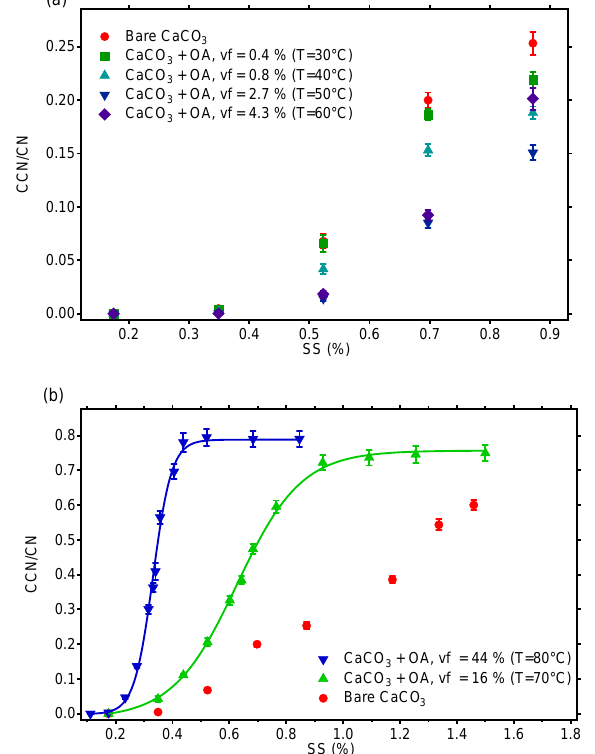
Figure 4. Activated fractions (CCN / CN) of monodisperse CaCO 3 aerosol particles (diameter d u = 101 . 9nm) at different supersatu- rations before and after OA coating. With increasing coating tem- peratures of 30–50 ◦ C the activated fraction decreases despite the increase of organic volume fraction (vf) from 0.8 to 2.7%. At a vf of 4 . 3% at 60 ◦ C this trend turns. Considering the increased particle diameter at 30–60 ◦ C and the reduced activated fraction simultane- ously, the CCN activity of the coated CaCO 3 particles at 30–60 ◦ C was lower than that of the uncoated CaCO 3 particles (a) . At coating vf of 16 and 44% ( T = 70–80 ◦ C) the activated fractions, and thus CCN activities, are higher than for bare CaCO 3 and increase with coating vf. In these two cases all particles are activated at the high- est SS and SS crit and κ can be determined from the turning point of the sigmoidal fit ( b , compare Table 1).